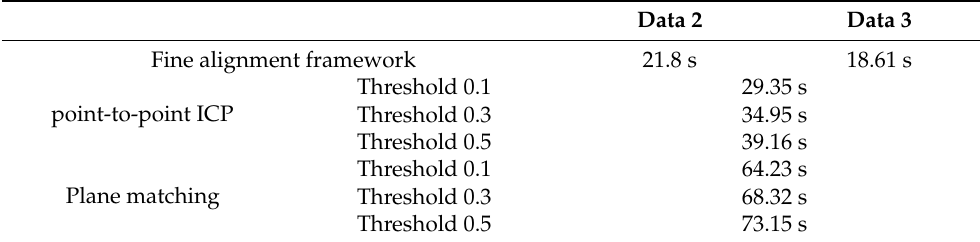
Table 4. Run time of the proposed framework and two registration